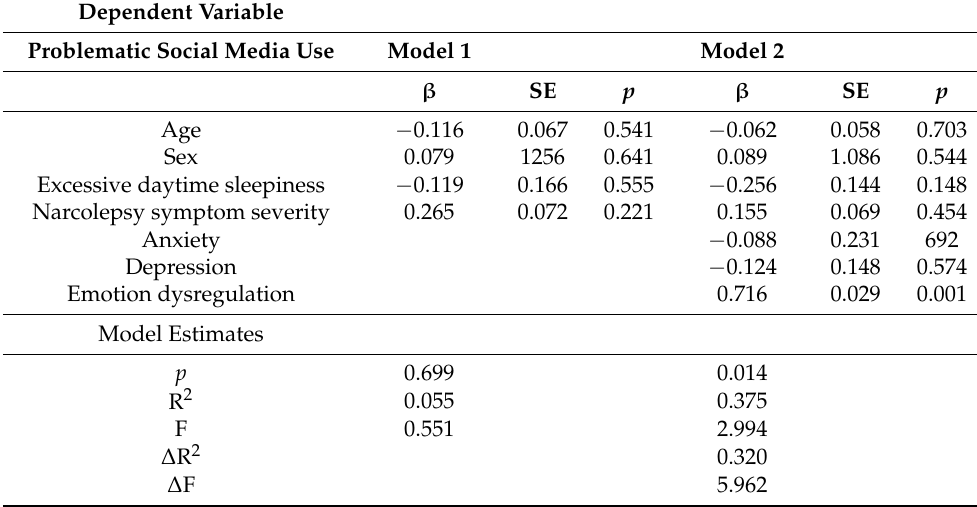
Table 4. Hierarchical multiple regression predicting problematic social media use